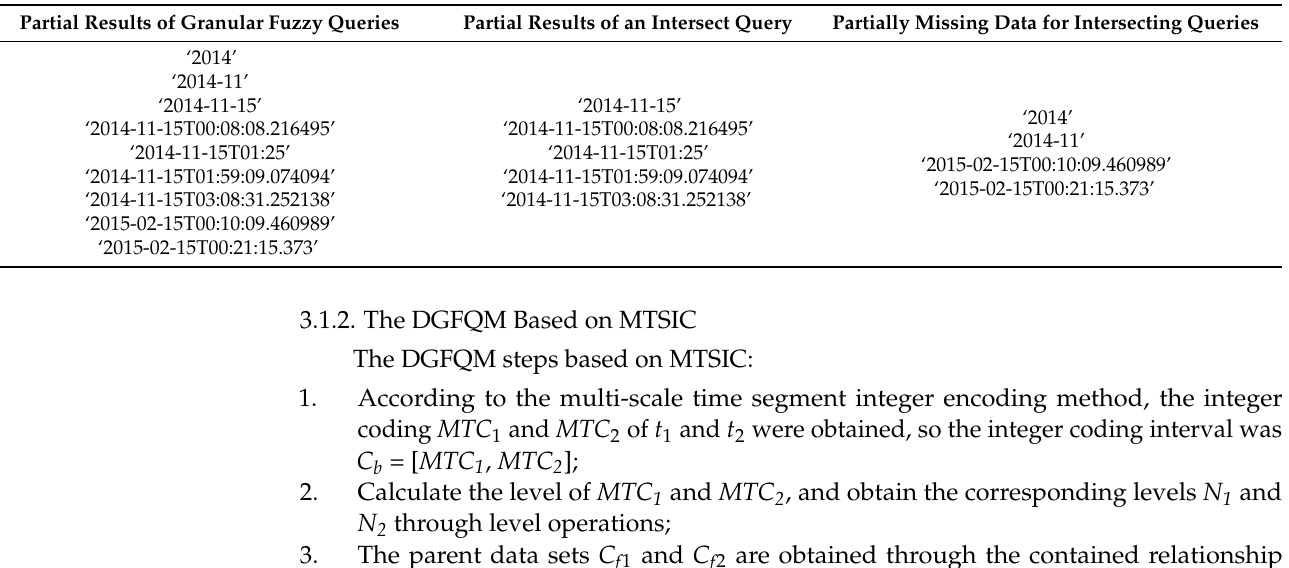
Table 2. Two query results based on the string